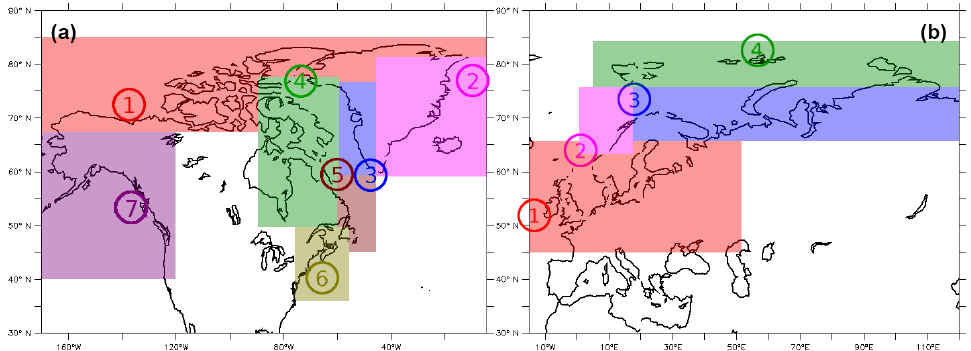
Figure 5. The upstream ocean temperature profile sites and corresponding downstream sectors assigned to these profiles for ocean–ice coupling in (a) NA and Greenland and (b)